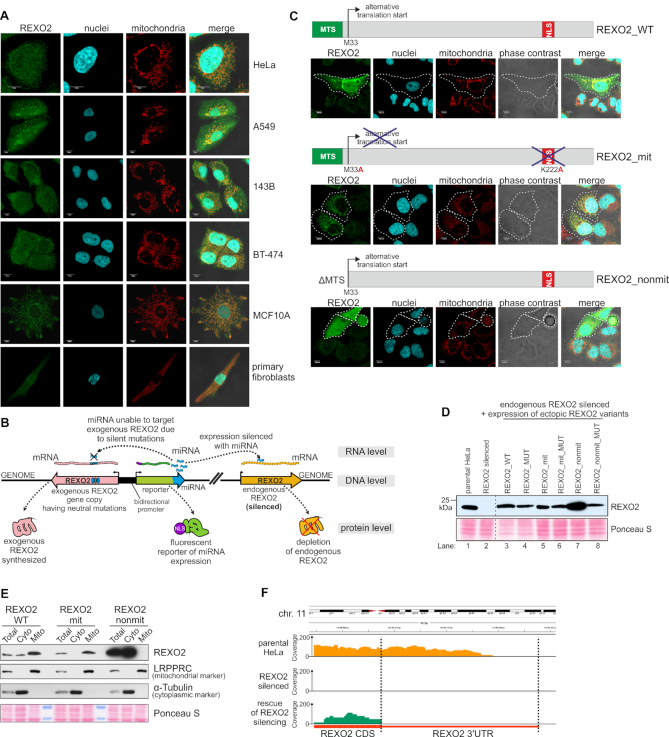
The established cellular model allows functional studies of REXO2 in mitochondria. (A) Intracellular localization of endogenous REXO2 in different cell lines by confocal microscopy. Immunofluorescence was performed using anti-REXO2 antibodies. Nuclei and mitochondria were stained with Hoechst and MitoTracker CMXRos Red, respectively. Scale bars represent 10μm. (B) Schematic model of the engineered cell lines. (C) Schematic representation of ectopic REXO2 variants and their localization verified by transient transfection followed by anti-REXO2 immunofluorescence. Dashed lines indicate transfected cells. REXO2_WT, full-length wild-type protein; REXO2_mit, protein localized only to mitochondria; REXO2_nonmit, truncated REXO2 that lacked the mitochondrial targeting sequence. (D) Western blot analysis of REXO2 levels in engineered cell lines. Anti-REXO2 antibodies were used. PonceauS staining was used as a loading control. (E) Western blot analysis of exogenous variants of REXO2 in total, cytoplasmic, and mitochondrial fractions. LRPPRC and α-tubulin were used as markers of mitochondria and the cytoplasm, respectively. PonceauS staining was used as a loading control. (F) Analysis of REXO2 silencing efficacy at the RNA level. Tracks of RNA-seq reads mapped to the REXO2 gene. Parental HeLa cells (parental HeLa), cells with silenced REXO2 (REXO2 silenced), and cells that expressed ectopic REXO2_WT that replaced the miRNA-silenced endogenous copy of REXO2 (rescue of REXO2 silencing) are shown.